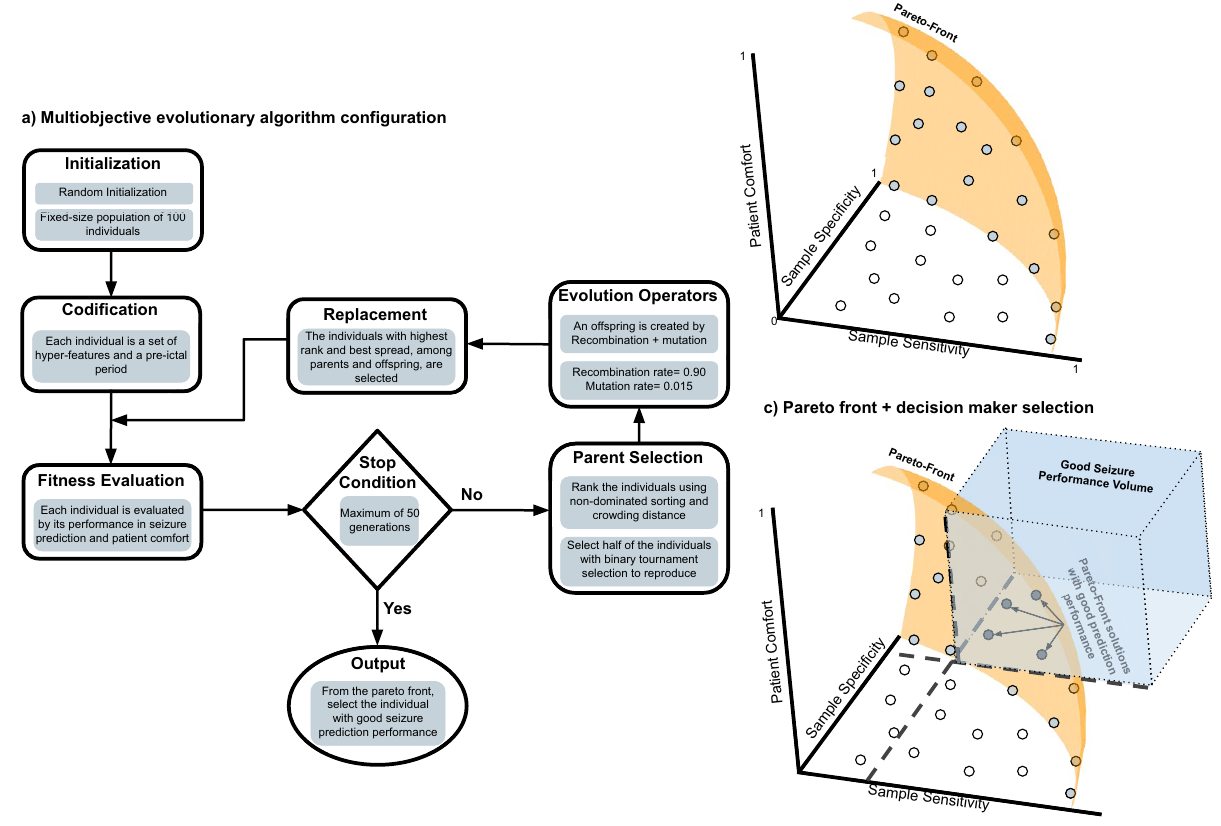
Figure 2. ( a ) The proposed MOEA configuration, ( b ) Pareto-front definition, and ( c ) the Decision Maker selection on the Pareto-front for selecting the individuals after the MOEA execution, where ( b , c ) reflect